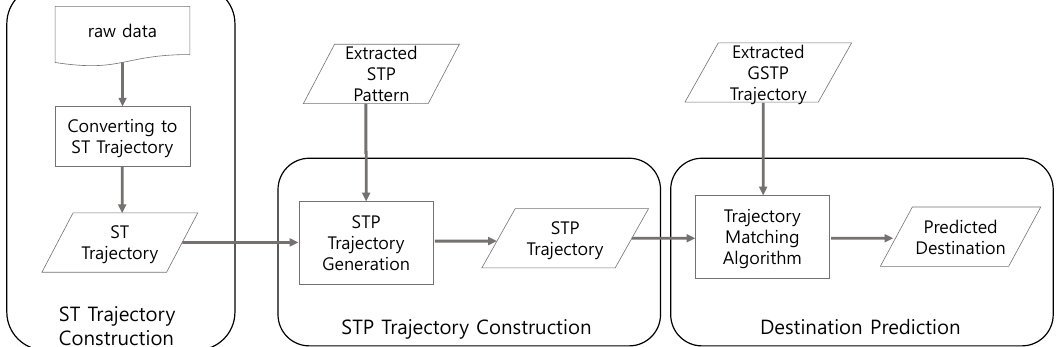
Figure 3. The test process for predicting next places based on raw test